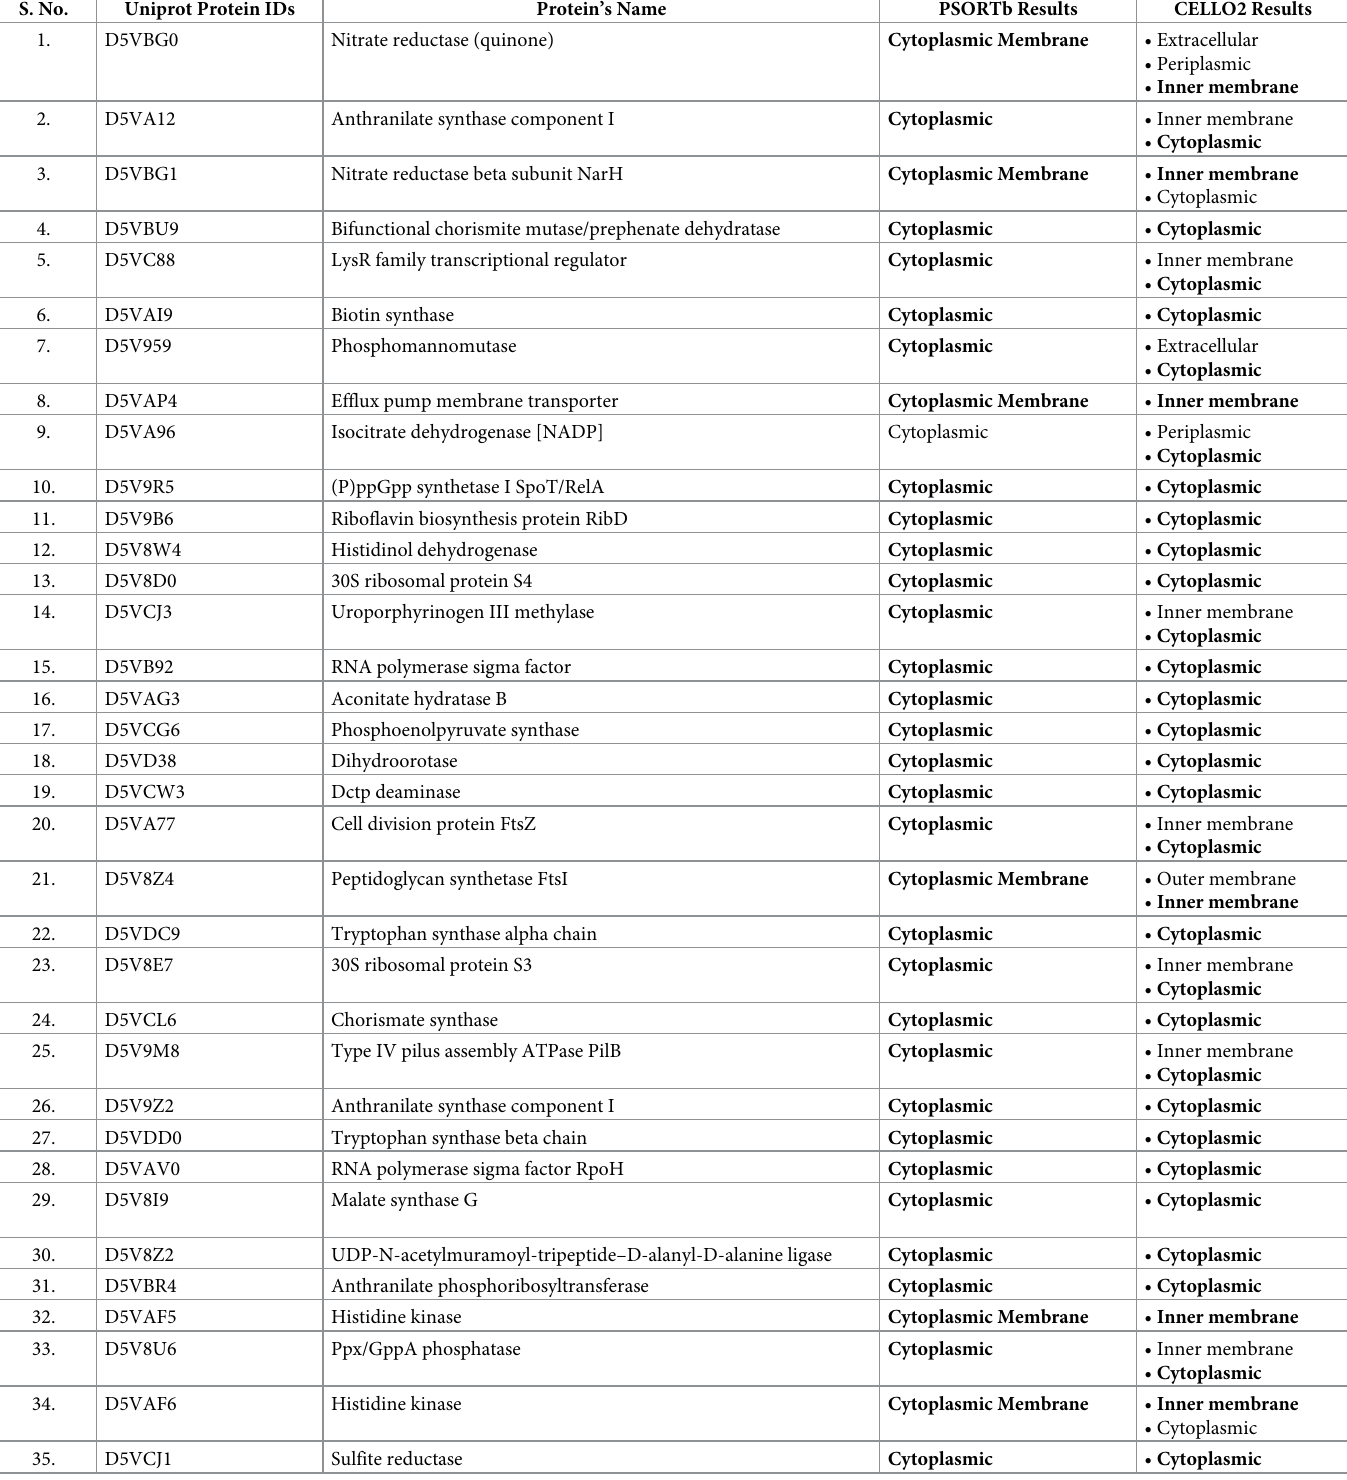
Table 2. Subcellular localization: Distribution of essential non-homologous proteins in a different area of cell. S.